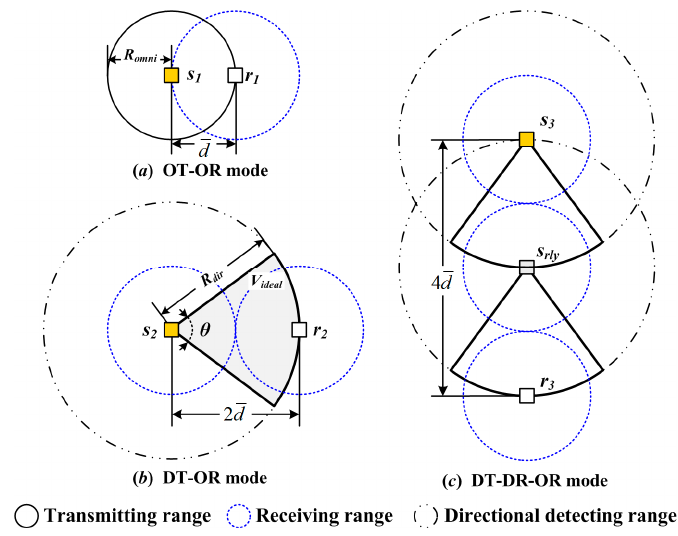
Figure 2. Transmission modes with adaptive antenna.